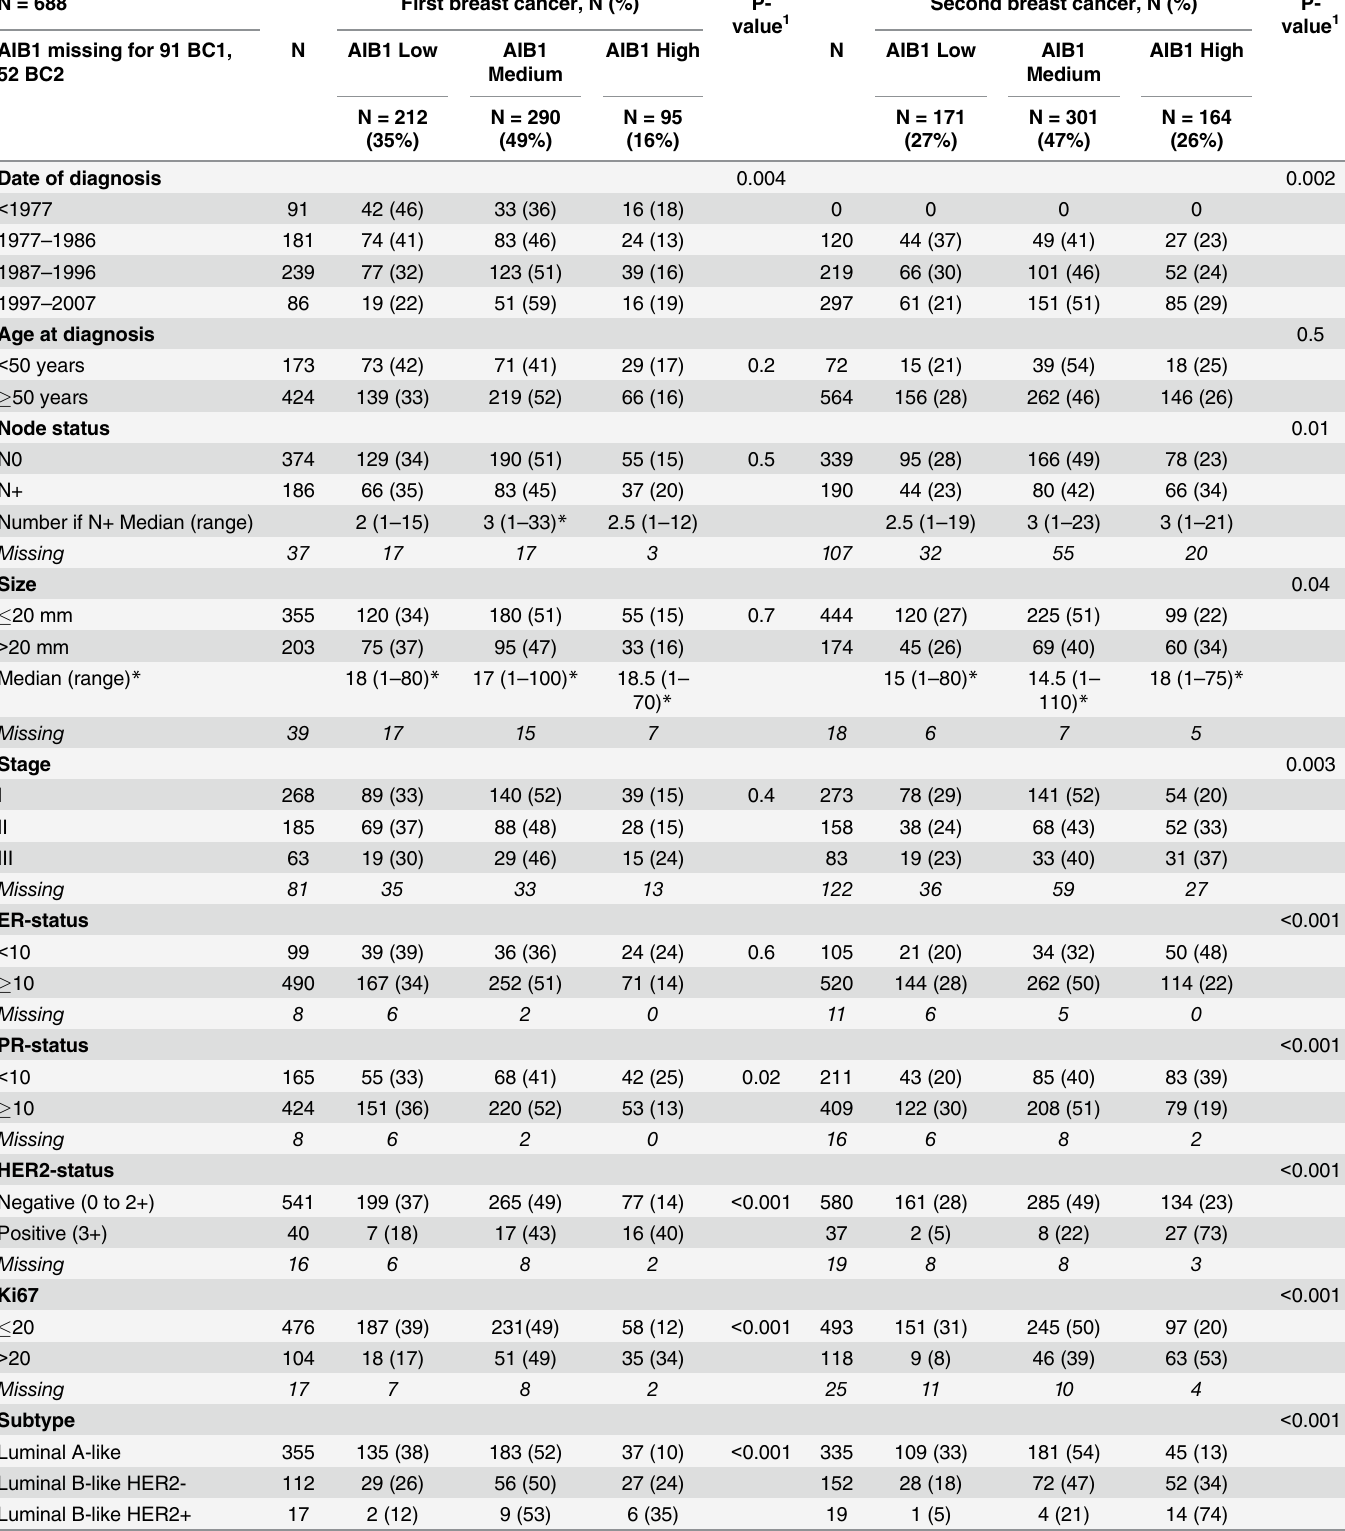
Table 1. Patient and tumor characteristics in relation to